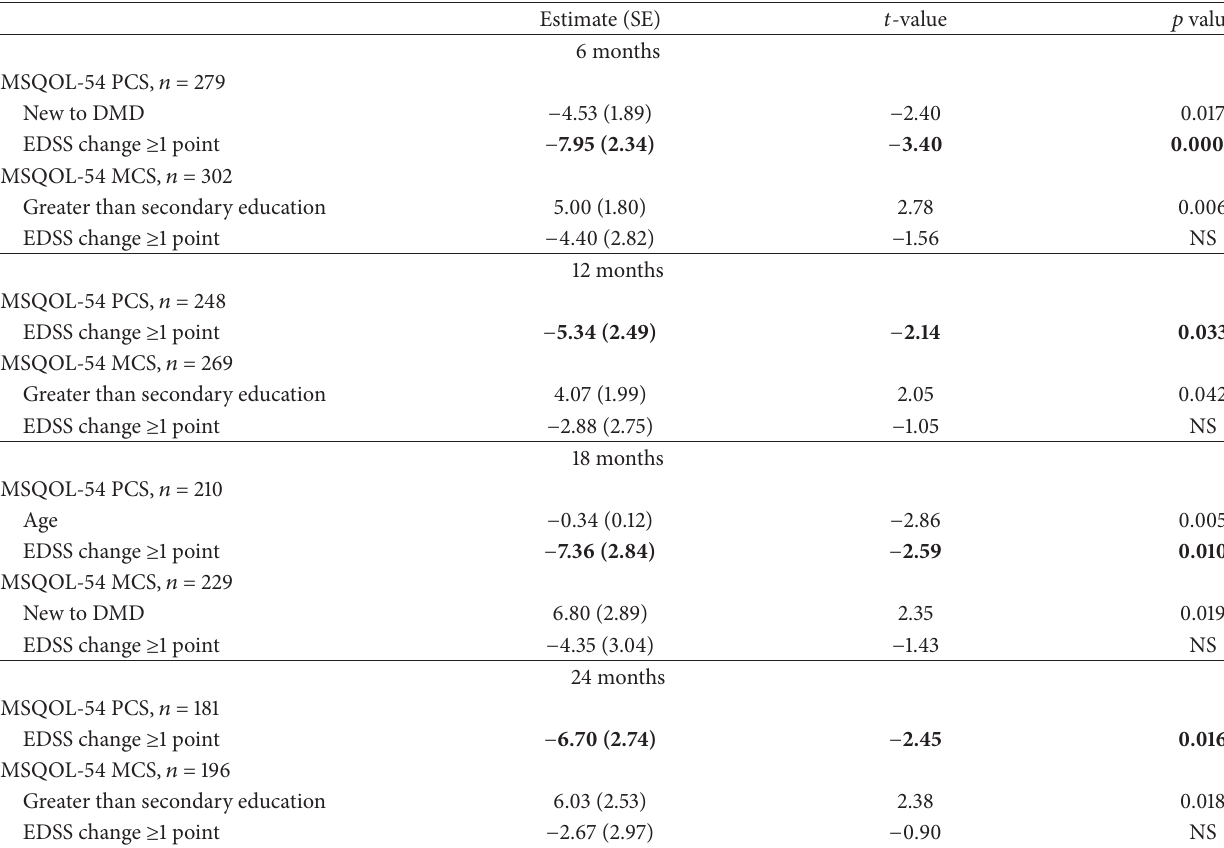
Table 3: Results of multivariable analyses: unique associations of EDSS score increase of ≥ 1 point with follow-up MSQOL-54 PCS and